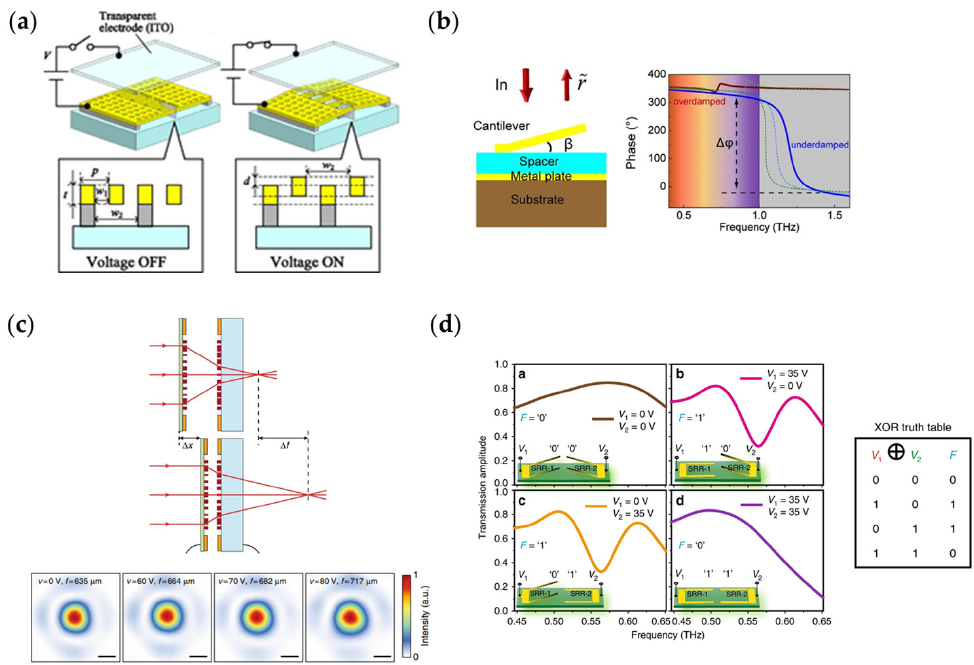
Figure 13. ( a ) Dual refractive metasurface system in the visible light band. Reprinted with permis- sion from [257], copyright 2023 AIP Publishing; ( b ) MEMS reconfigurable metasurface realizing dynamically polarization control and holography. Reprinted with permission from [98], copyright © 2000–2023 by John Wiley and Sons, Inc. or related companies. All rights reserved; ( c ) A